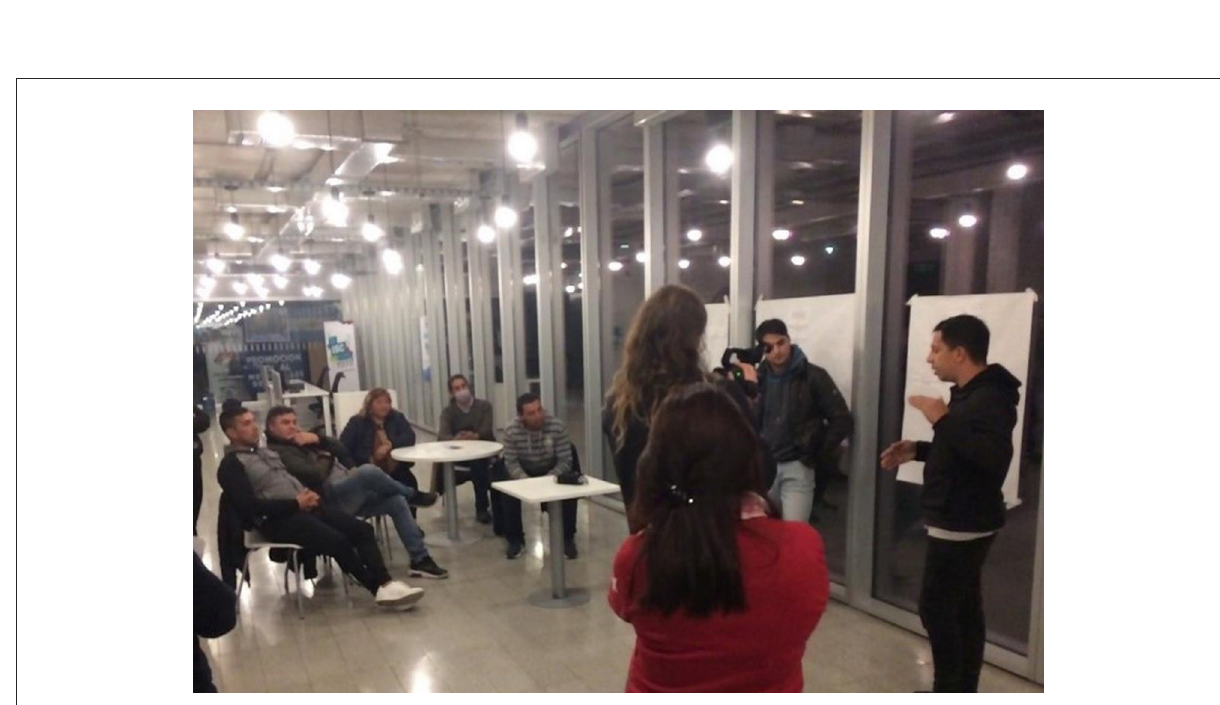
FIGURE6 Urban Lab Buenos Aires, 3rd meeting, May 2022. Source TUC